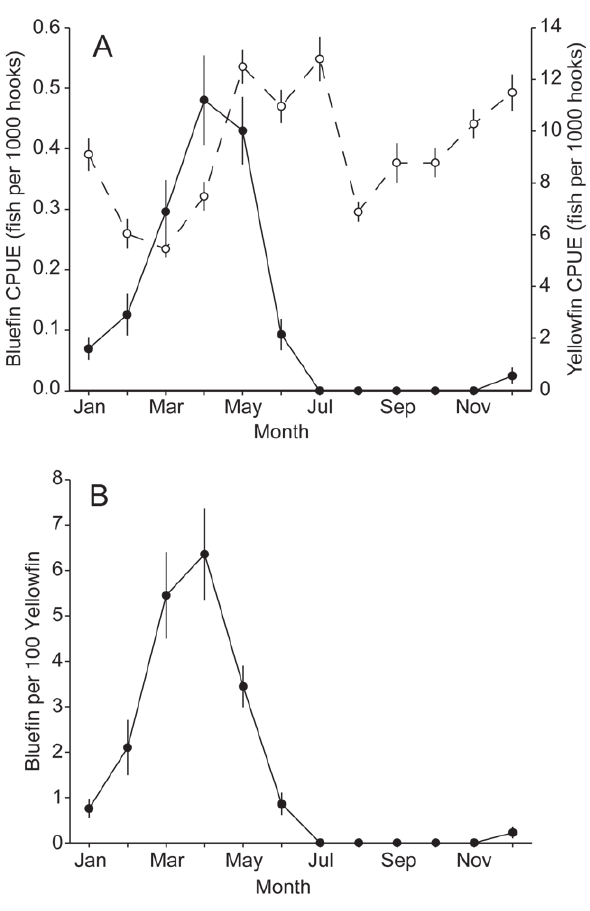
Figure 3. Mean and relative bluefin and yellowfin tuna CPUE. Circles indicate monthly mean (A) catch per unit effort (CPUE) of bluefin (closed circles) and yellowfin tuna (open circles) in the Gulf of Mexico, and (B) mean ratio of number of bluefin to 100 yellowfin caught. Error bars indicate 1 sd (based on 1000 bootstrap samples).